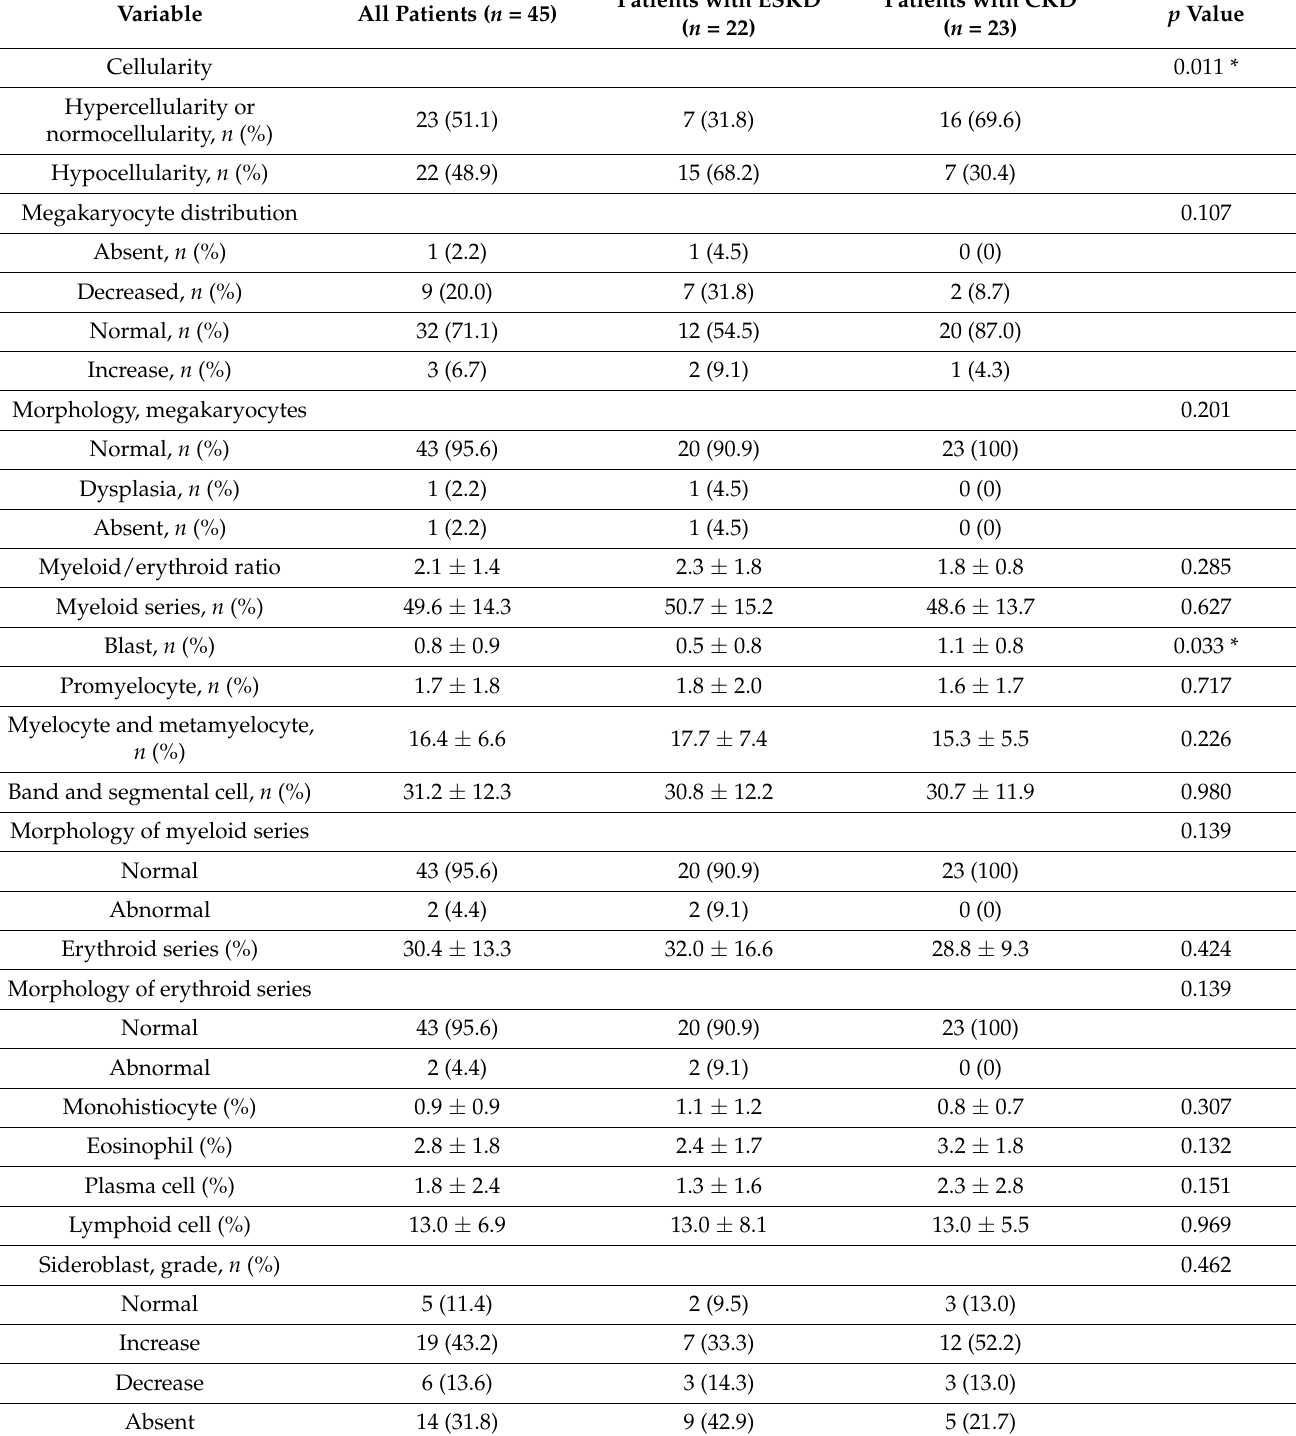
Table 5. Reports of bone marrow aspiration ( n =